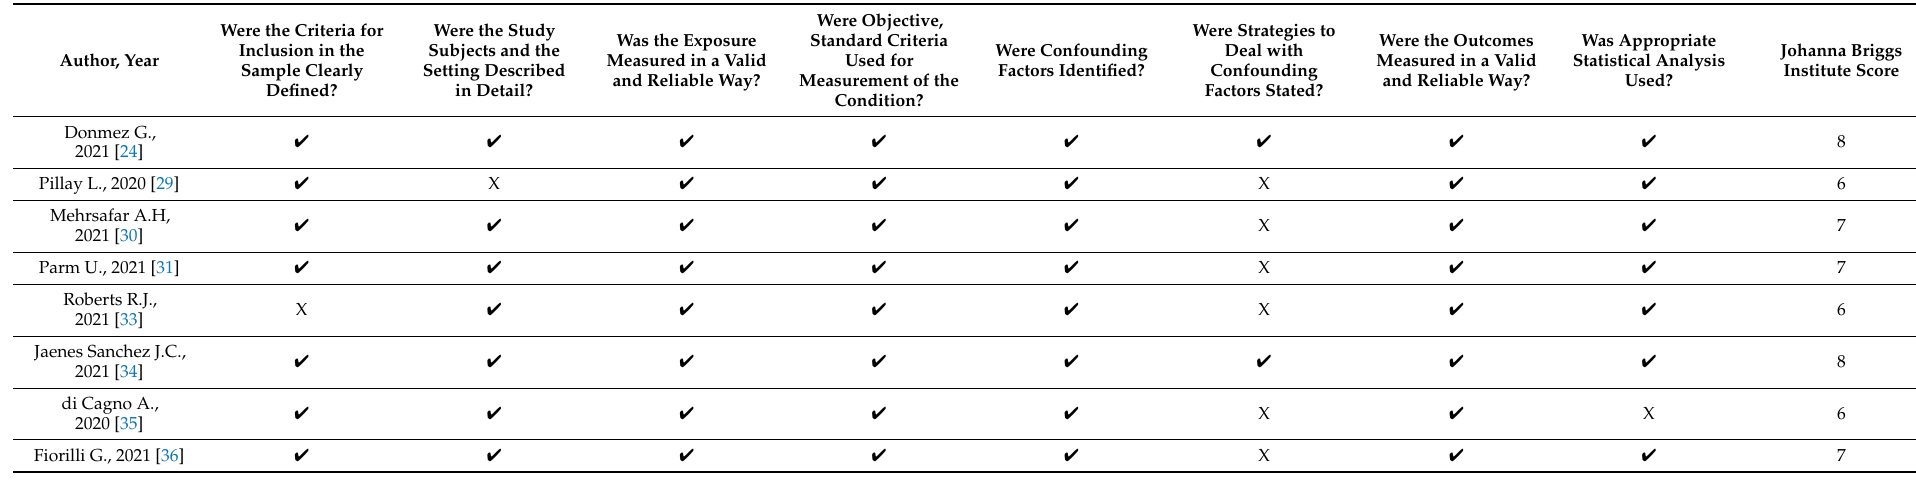
Table 4. Critical appraisal of cross-sectional